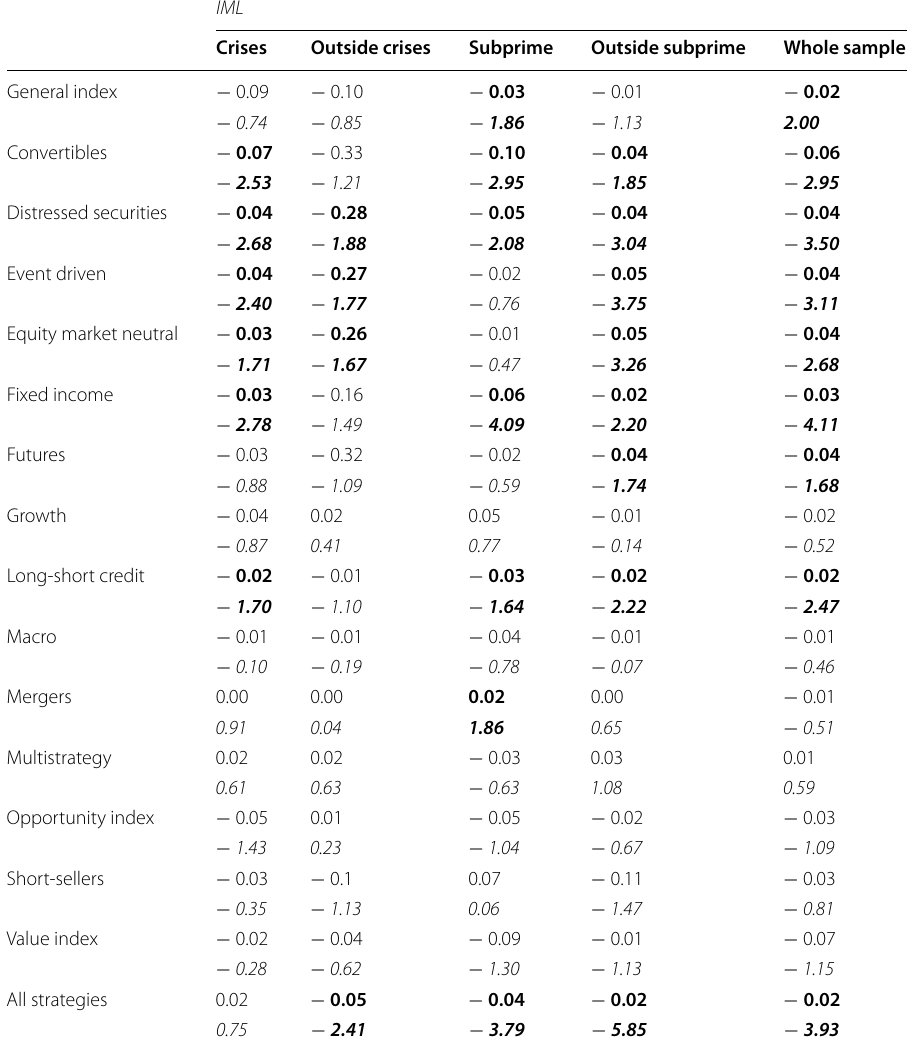
Table 5 Sensitivities of hedge fund strategies’ betas to IML using pooled regressions with fixed coefficients and SUR,